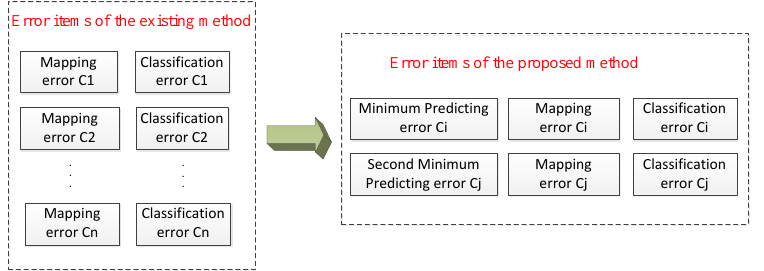
Figure 3. Differences between error terms of existing methods incorporating scene labels and our proposed method.